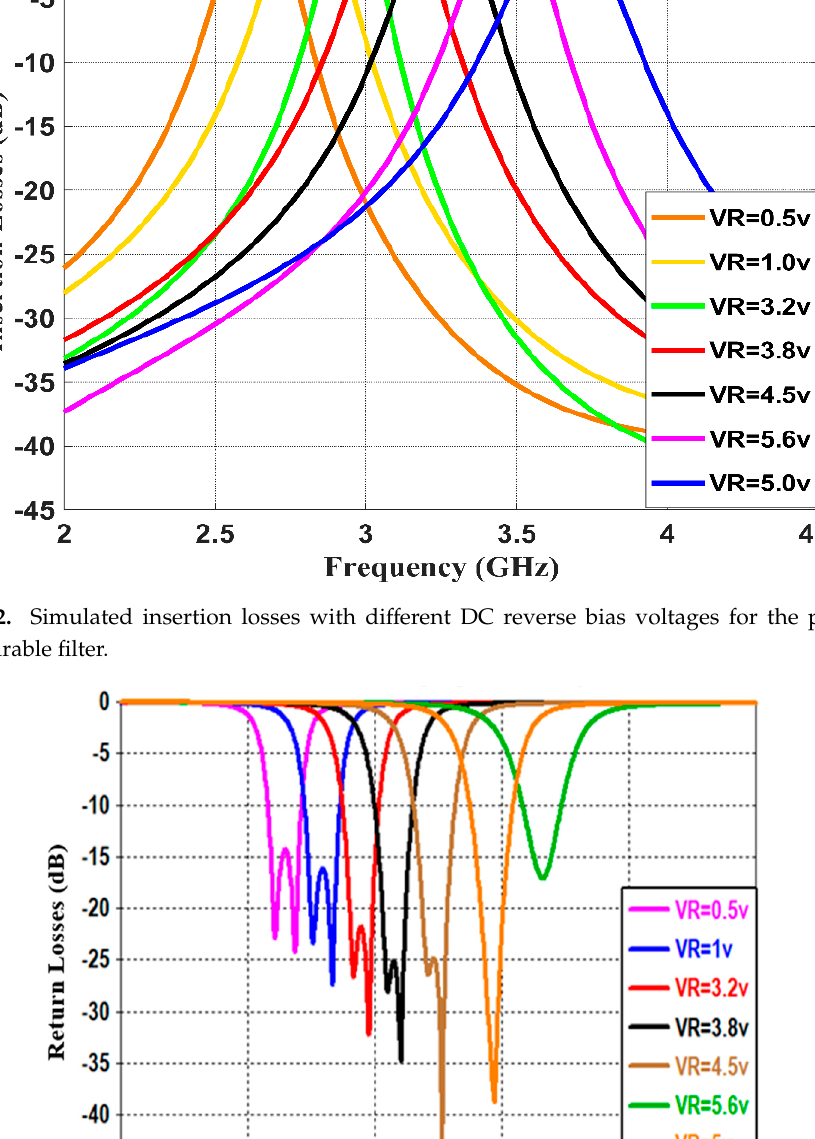
Figure 11. Simulated return losses with different DC reverse bias voltages for the presented reconfigurable filter.